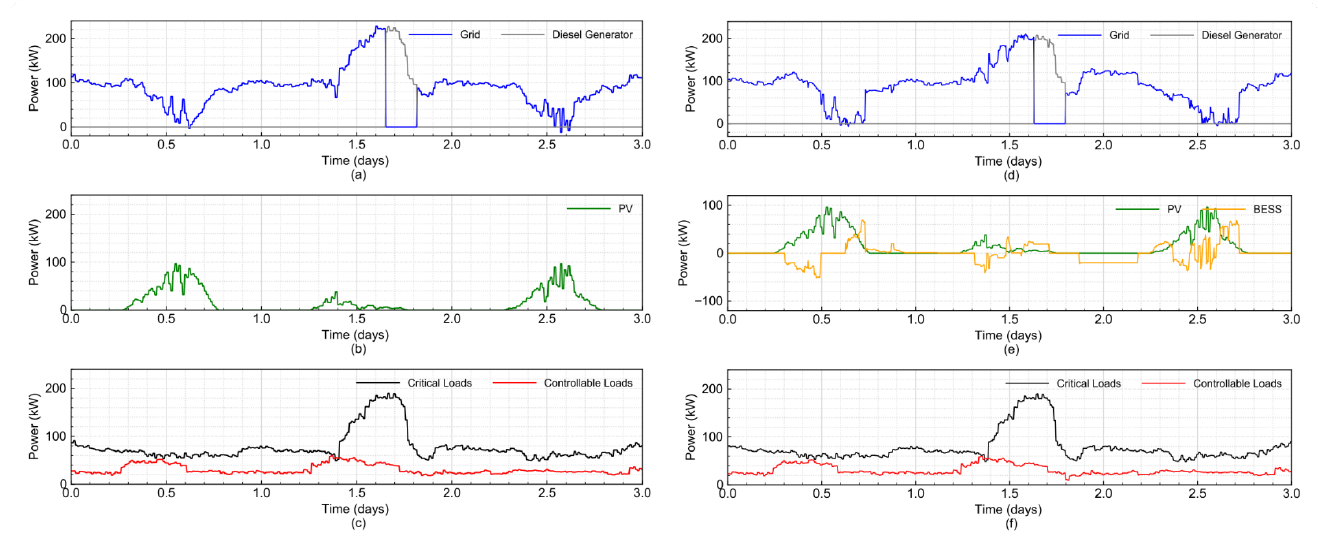
Figure 6. COGE MG operation: ( a – c ) without E+BOX and ( d – f ) with E+BOX and setpoints defined by the optimizer in the